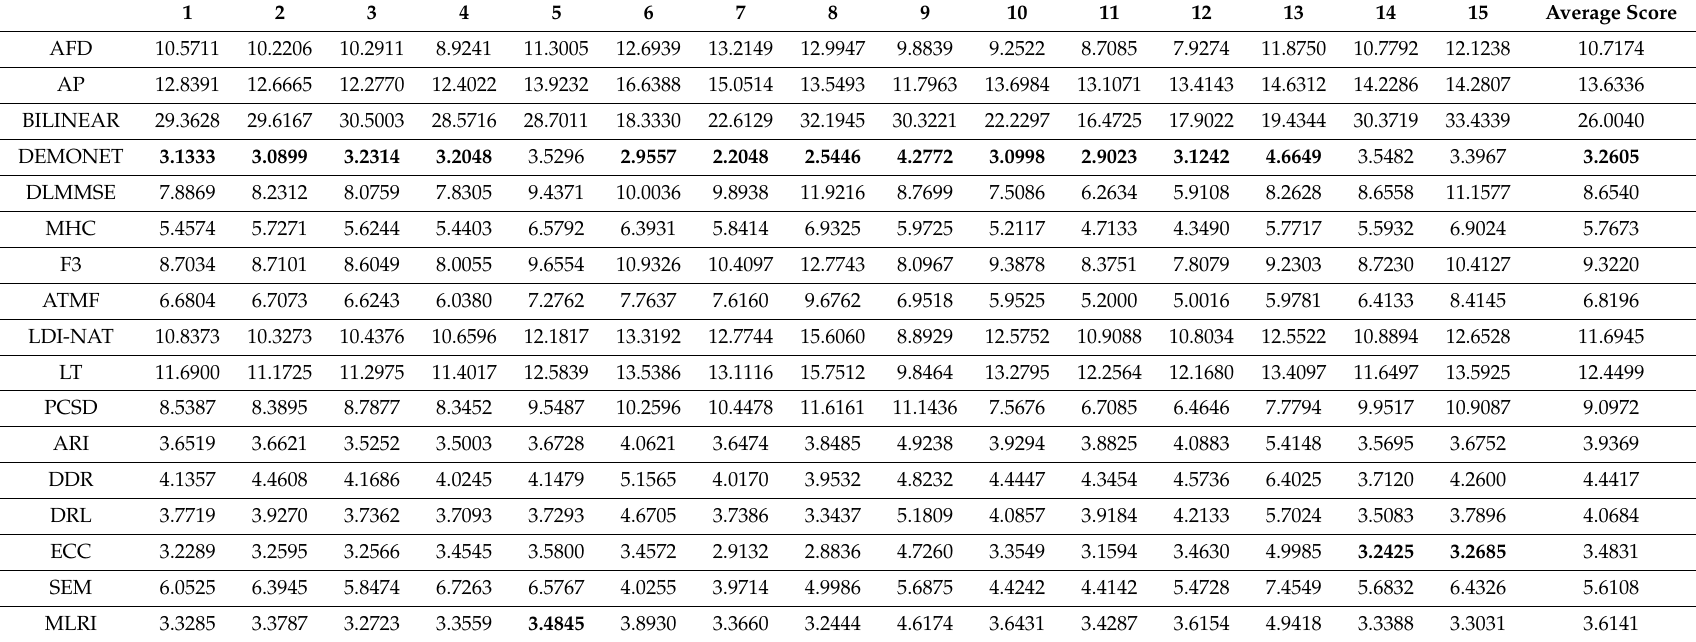
Table 8. Summary of NIQE scores (lower = better). Fifteen right images. Average of RGB